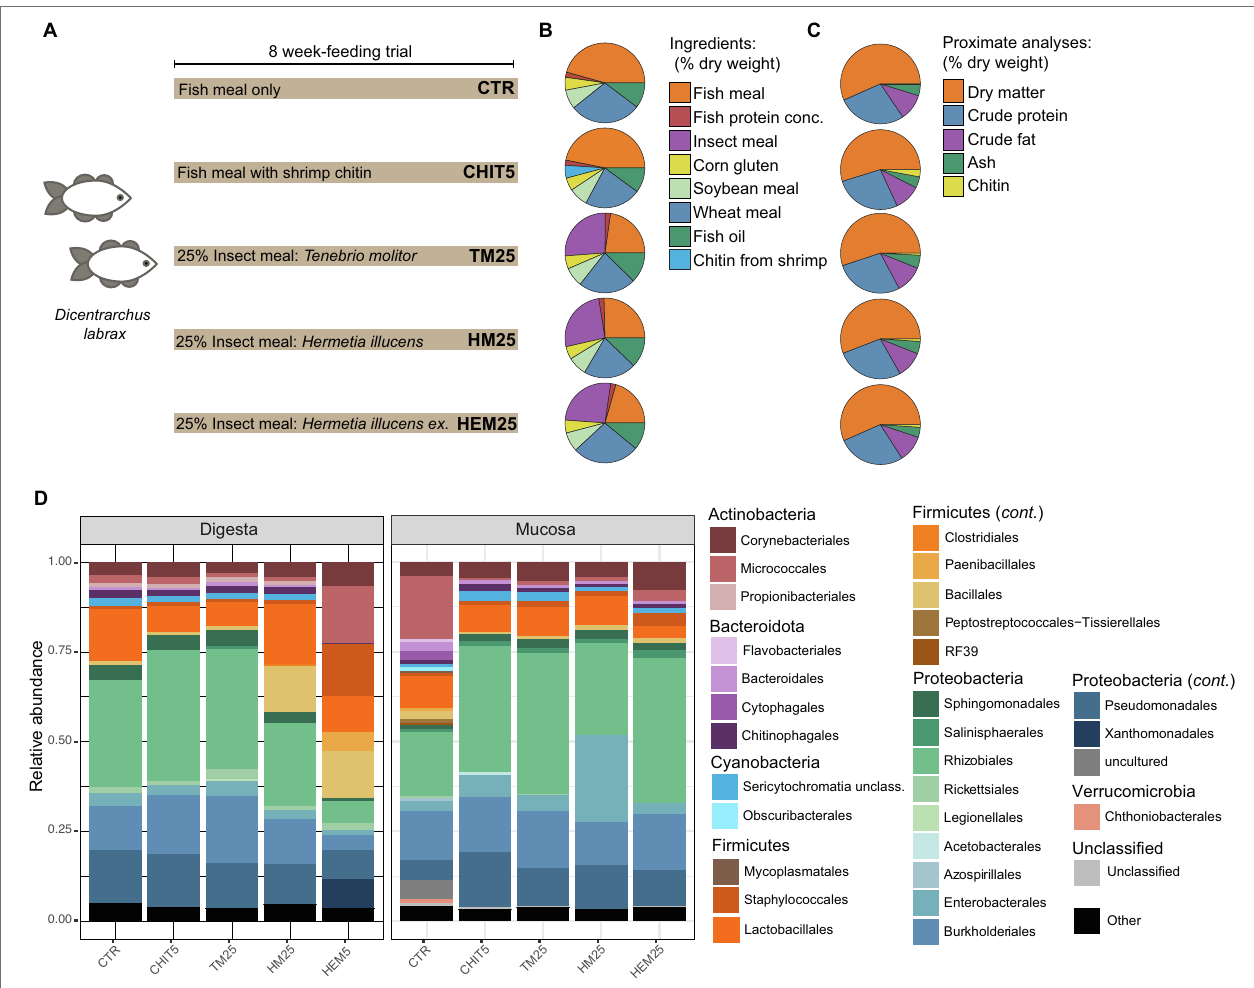
FIGURE 1 | Feeding diets and gut microbiota composition of the European sea bass. (A) Three tanks containing 15 Dicentrarchus labrax fish each were fed with the five different depicted diets for 8 weeks (see Materials and Methods). ex , exuviae. Three different tanks per diet were included in the trial. (B) Percentages (dry weight basis) of the different ingredients in each diet. Only major ingredients (final percentage in diet >1.0%; Supplementary Table 1 ) are shown. (C) Despite different compositions, proximate analyses show that all diets contain similar amounts of dry matter, crude protein, crude fat and ash, while levels of chitin are rather more variable ( Supplementary Table 1 ). (D) Phylum- and Order-level relative abundance profile of the gut microbiota of digesta and mucosa samples from fish fed the different diets depicted in (A) . Orders with <1% relative abundance are collapsed into the category “Others.” Each bar represents the average of three different samples per diet for each habitat, each sample originating from a different